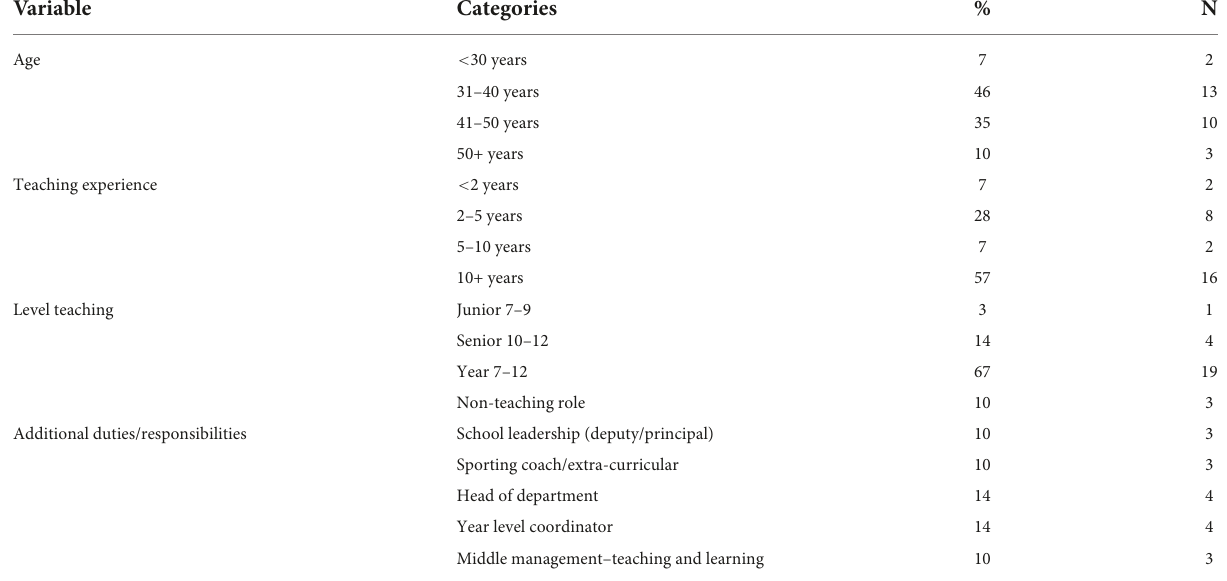
TABLE 1 Demographics of the teacher